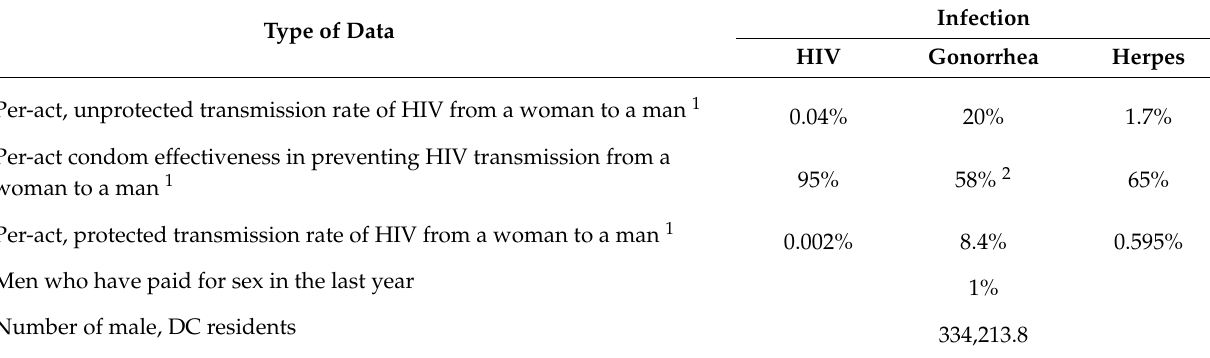
Table 5. Values of data used to calculate health sector savings due to averted cases of HIV, gonorrhea, and herpes in clients following decriminalization (monetary values in 2020